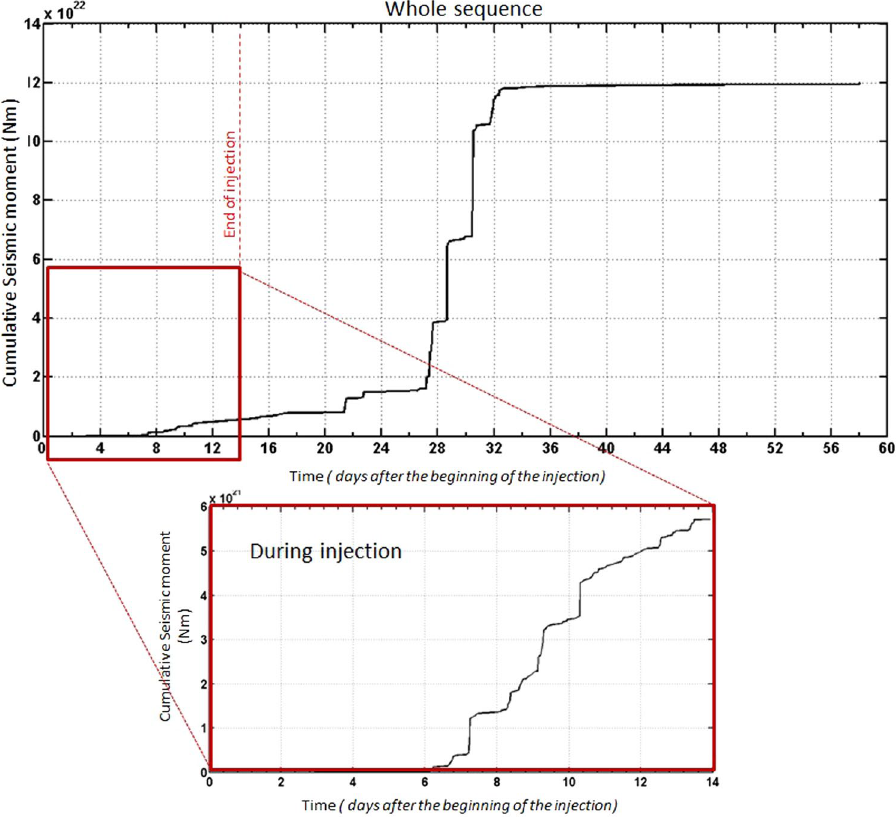
Figure 9. Cumulative seismic moment releases during the whole sequence with a zoom on the cumulative seismic moment releases during the injection. The figure was generated by using the ZMAP